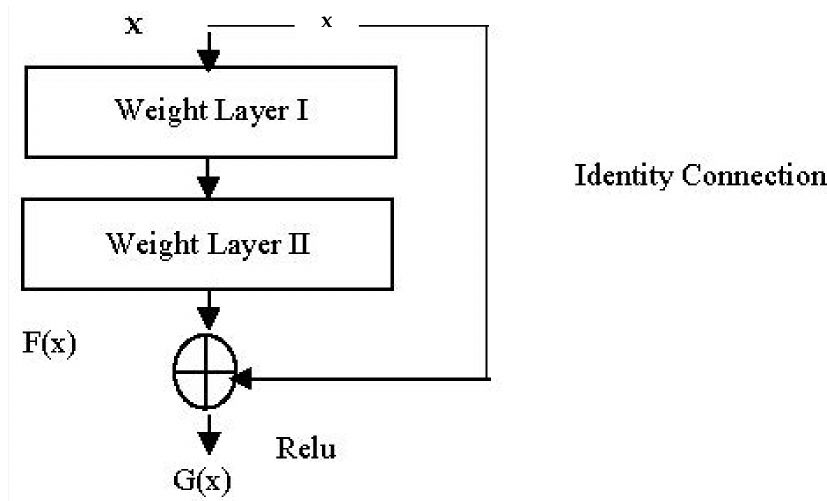
Figure 3. Residual Network with identity